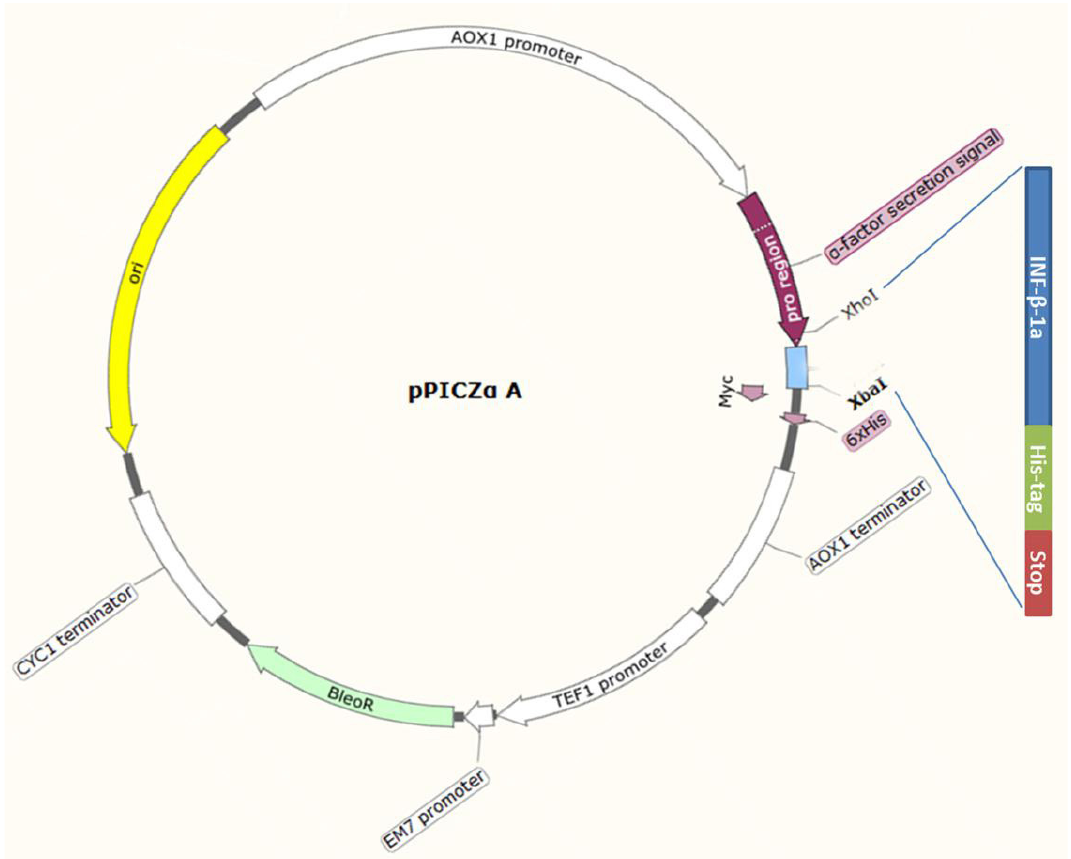
FIGURE 1 - Schematic diagram of pPICZαA–INF-β-1a expression vector